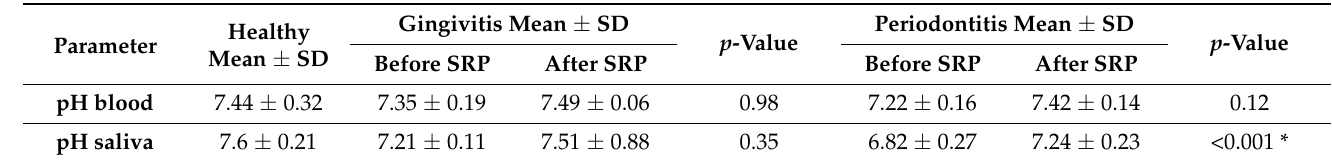
Table 2. Differences between pH in saliva and blood of healthy, before and after periodontal treatment in gingivitis and periodontitis